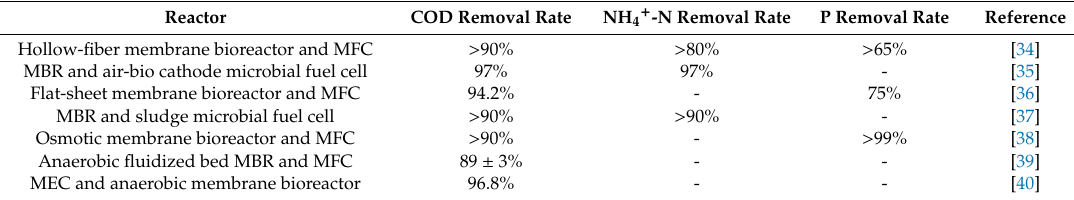
Table 1. The removal e ffi ciencies of COD, NH 4 + -N, and P in di ff erent microbial electrocatalysis systems coupled with MBR